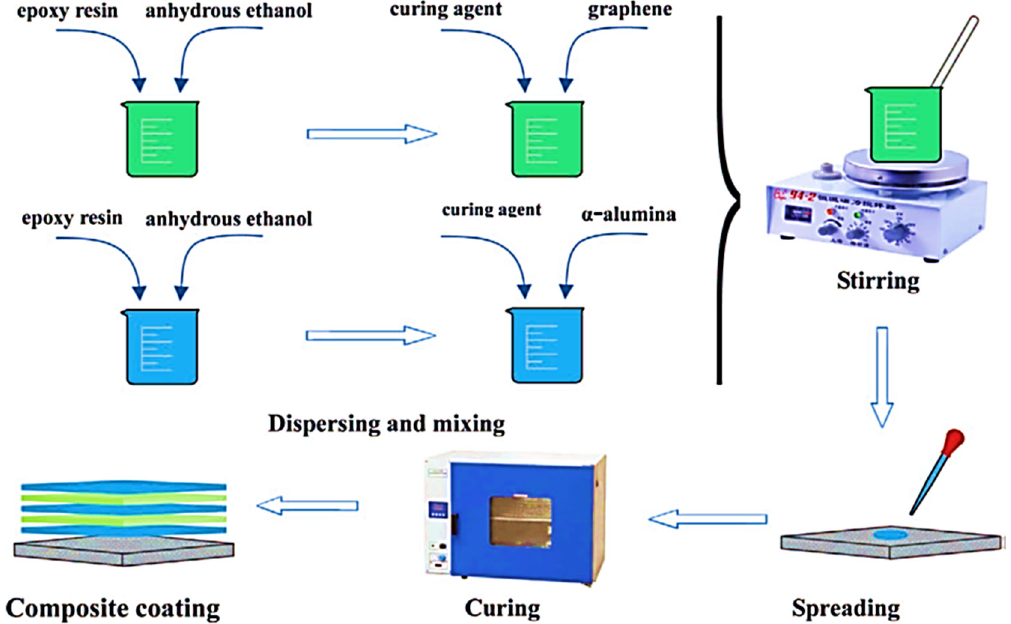
Figure 2. Preparation process of corrosion-resistant multifunctional epoxy nanocomposite coating [70]. Reproduced with permission from